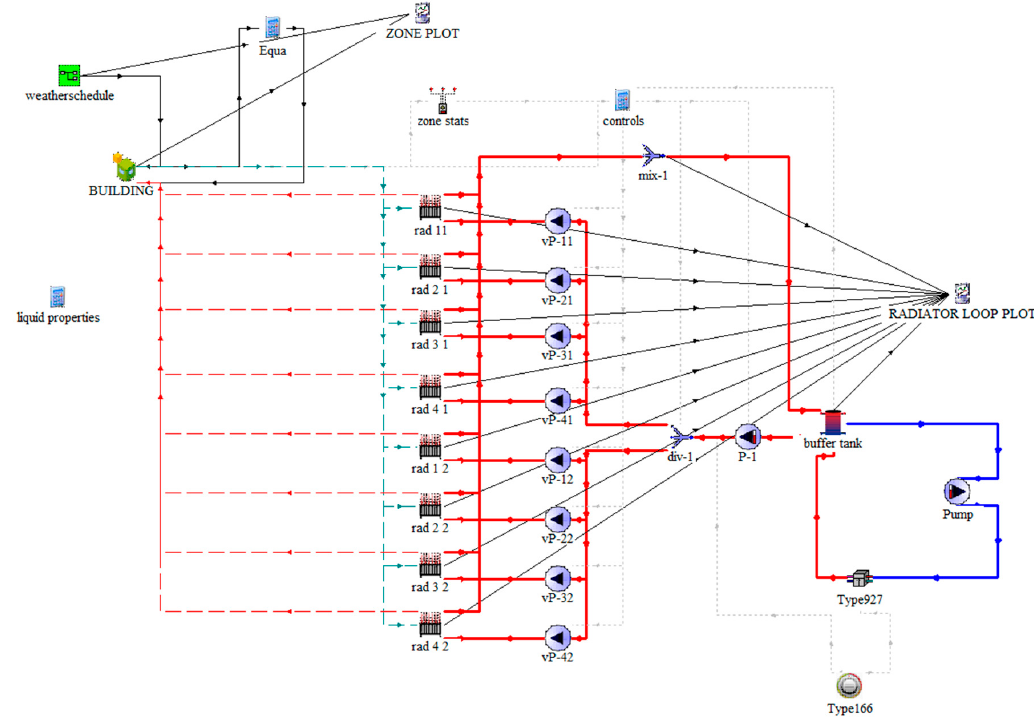
Figure 6. TRNSYS model used for heat pump supply